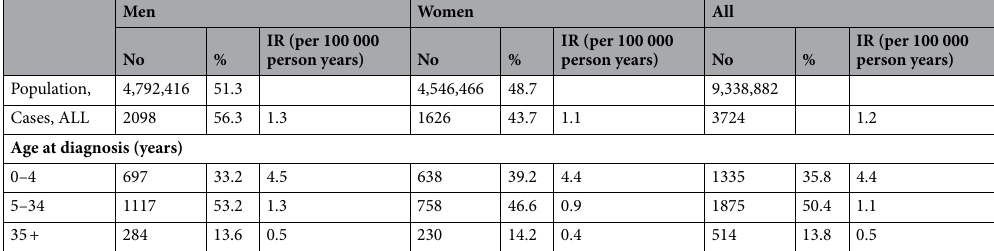
Table 1. Characteristics of study population, number of cases and incidence rate (IR, per 100 000 person years) of acute lymphoblastic leukemia (ALL) in Sweden,